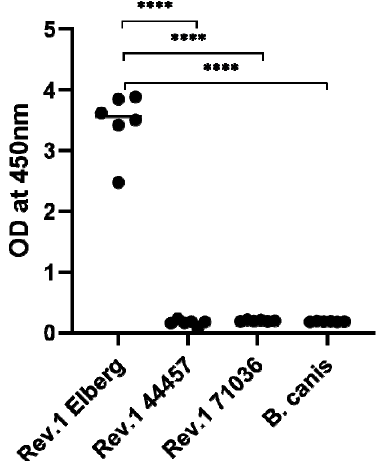
Figure 4. Whole cell immunoassay demonstrating the absence of surface O-polysaccharide (O-PS) in the natural rough Brucella melitensis Rev.1 71036 and 44457 vaccine strains. The evaluation of Brucella surface O-PS was determined using a purified Murine anti- Brucella O-PS Monoclonal antibody as described in Section 3. B. melitensis Rev.1 Elberg (smooth phenotype) was used as a positive control and B. canis (rough phenotype) as a negative control (**** = p < 0.0001, t test).